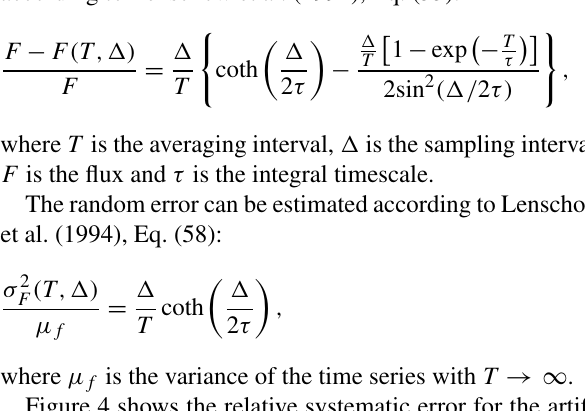
Figure 5. Random error of toluene flux with increasing DEC sam- pling interval (cid:49)t determined by artificially created DEC datasets following a square-root